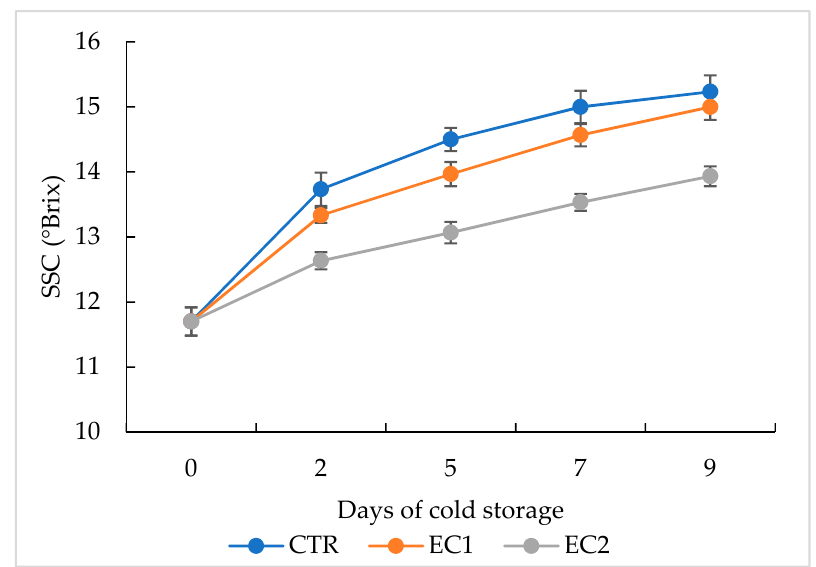
Figure 5. Evolution of soluble solids content (SSC) measured during 9 days of cold storage. Data correspond to the mean and bars indicate the standard deviation (SD) of three replicates (n = 3).